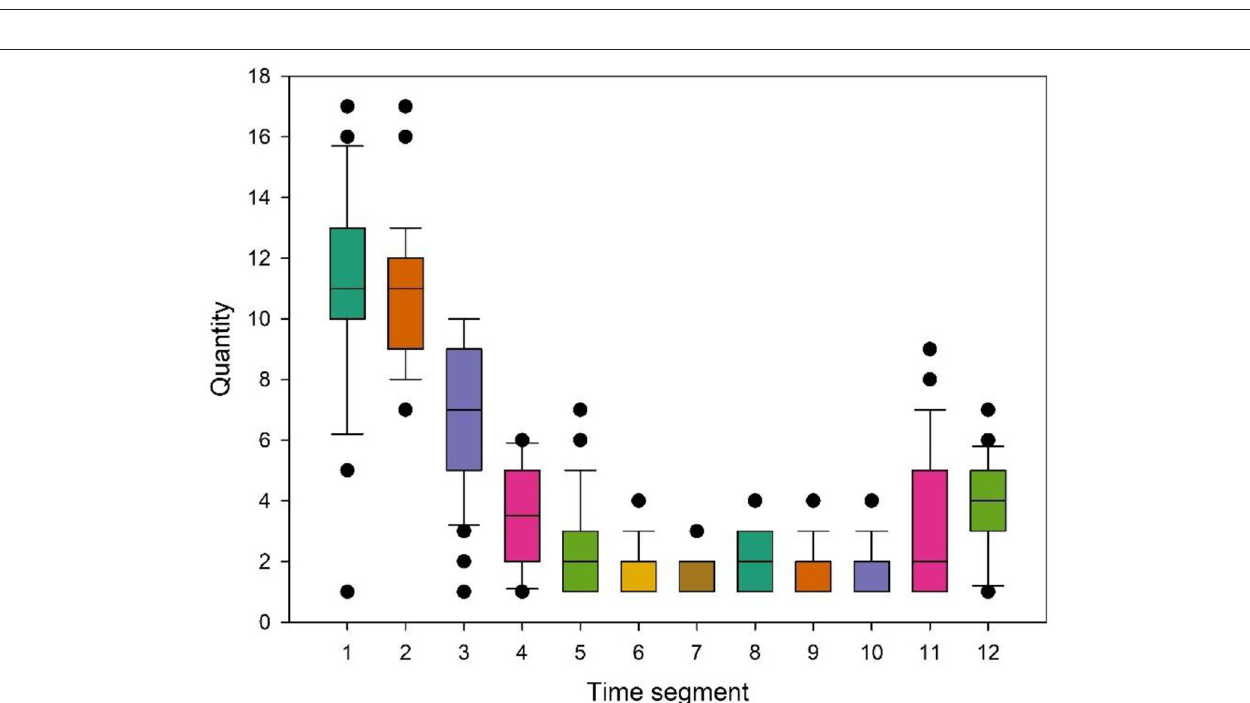
FIGURE 2 | Box plot of the number of articles on WeChat official in each time